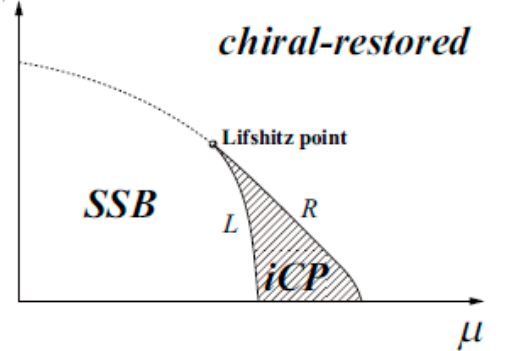
Figure 1. Schematic picture of the QCD phase diagram in the ( T , µ ) -plane. Inhomogeneous chiral phase (iCP) may appear near the chiral transition, and spontaneously symmetry broken (SSB) phase, chiral-restored phase, and iCP meet at the triple point called the Lifshitz point.